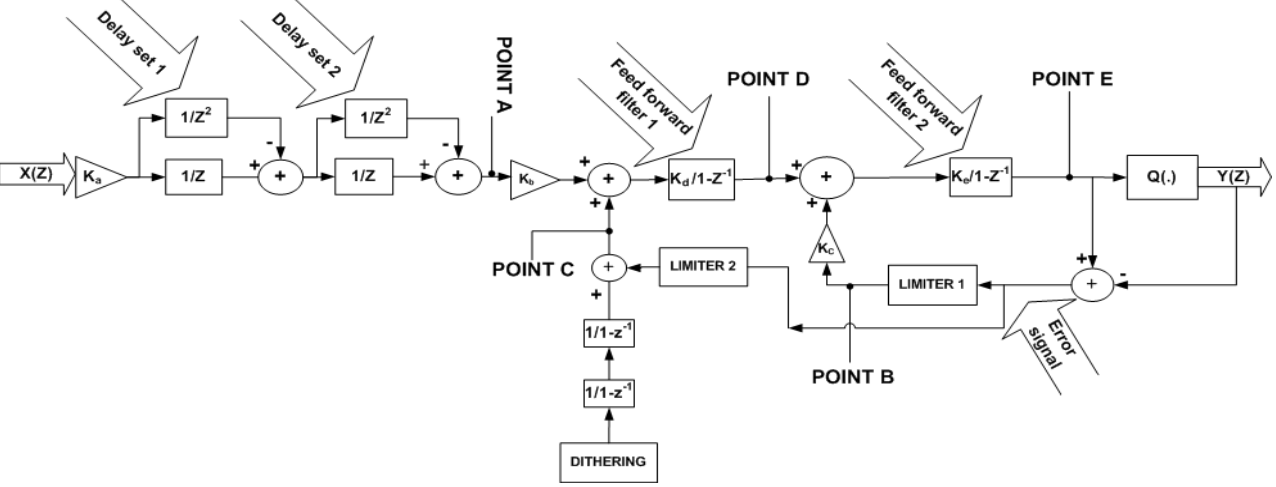
Figure 2. A New Proposed MASH-EFM architecture.